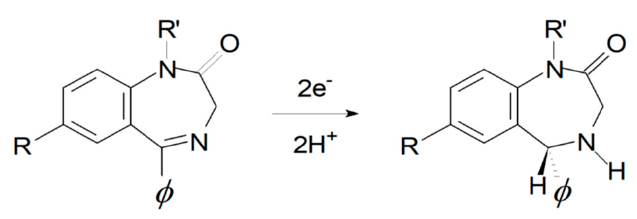
Figure 5. The oxidation of 4,5-azomethine redox mechanism.